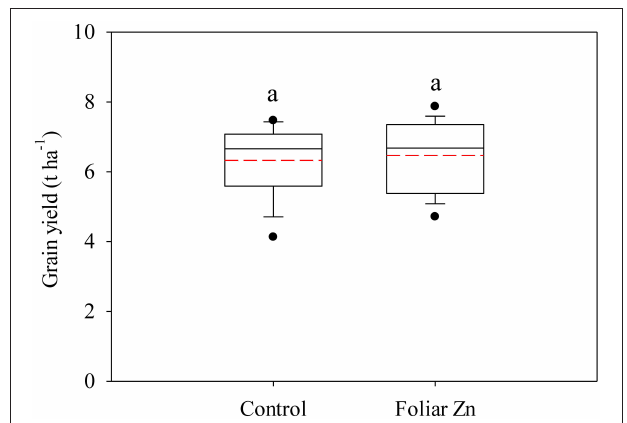
FIGURE 2 | Grain yield (14% water) as affected by foliar Zn application in Quzhou County. The solid and red dashed lines indicate the median and mean values, respectively. The same lowercase letter indicates no significant difference between the foliar Zn application levels via independent t- tests at the P < 0.05